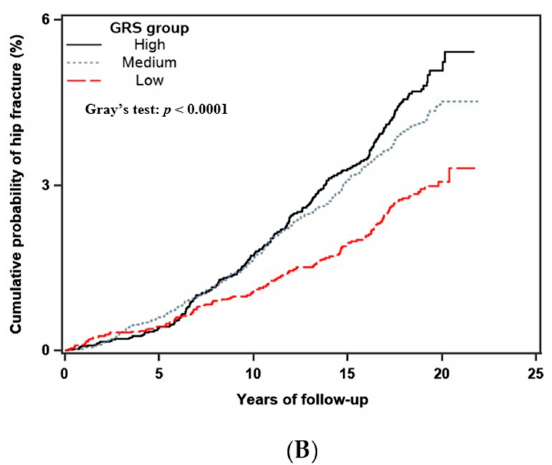
Figure 1. Crude (unadjusted) 10-year cumulative incidence of major osteoporotic ( A ) and hip fracture ( B ) stratified by the GRS group, including competing mortality risk. The difference in the cumulative incidence rates among different GRS groups was tested by using Gray’s test, with p -value <0.01 indicating a significant difference between the groups.